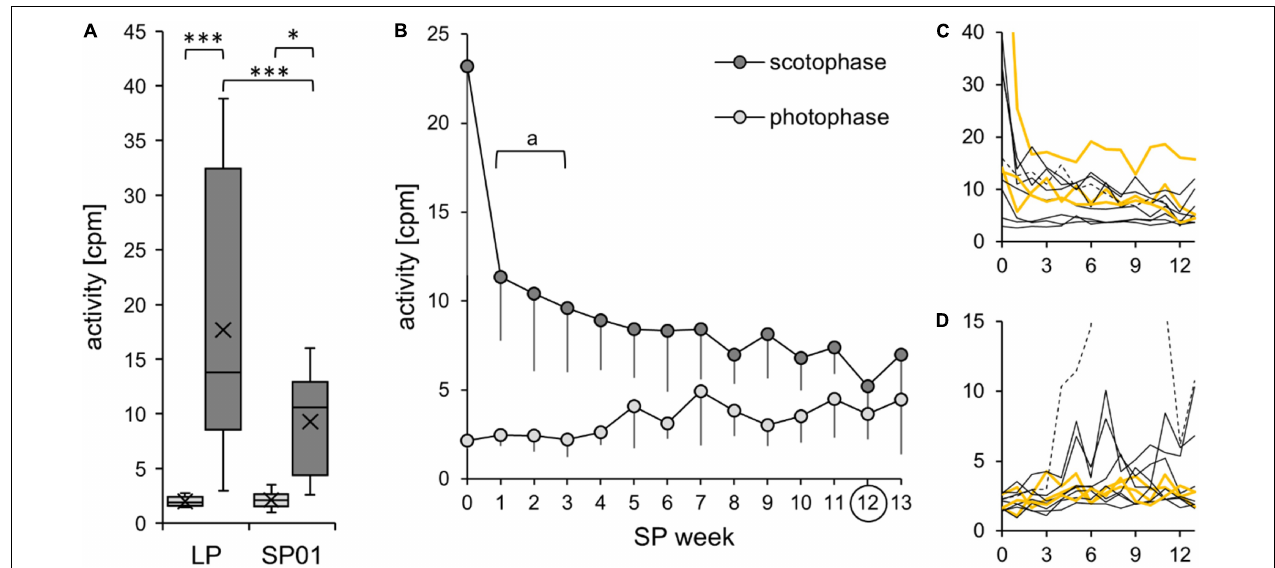
FIGURE 8 | Activity during the short photoperiod adaptation of approach 2. The exact values per hamster can be found in Supplementary Table 6 . (A) The cohort’s initial adaptation of activity after the change of the light regime ( n = 10). Comparison of activity during photophase ( light gray ) and scotophase ( dark gray ) of the last week of the long photoperiod ( LP ) and the first week of the short photoperiod ( SP01 ). According to the two-way repeated measures ANOVA, the activity was affected by both time frame [ F ( 1 , 9 ) = 21.155, p = 0.001, power = 0.984] and light regime [ F ( 1 , 9 ) = 7.689, p = 0.022, power = 0.637]. In addition, there was an interaction between the effects of time frame and light regime [ F ( 1 , 9 ) = 7.815, p = 0.021, power = 0.645]. Post hoc Holm–Sidak tests confirmed that the activity was significantly higher in LP scotophase (*** p < 0.001) and in SP01 (* p < 0.026) compared to that in photophase. Furthermore, scotophase activity was higher in LP than that in SP01 (*** p < 0.001), yet with a low power. Hamster #02 was excluded from the cohort’s model since it had an outlying scotophase activity level in LP (beyond the three times interquartile distance threshold of the cohort), with a drastic initial decrease from 79 cpm during LP scotophase to 25 cpm during SP01 scotophase. (B) Further activity development of the cohort ( n = 6). When comparing the adaptation period from SP01 to SP12, the scotophase activity was reduced. Significant differences to SP12 are indicated with “ a ” [one-way repeated measures ANOVA: F ( 12 , 60 ) = 4.750, p < 0.001, with Holm–Sidak p < 0.001]. The photophase activity slightly rose, yet with a significant difference from SP04 to SP08 only [Friedman repeated measures ANOVA: χ 2 ( 13 ) = 36.229, p < 0.001, with Tukey’s test p < 0.05]. Excluded were hamster #01, with high LP activity and an extremely slow activity adaptation to SP; hamster #02, with outlying LP activity; hamster #06, with stereotypic jumping behavior in the cage corners during photophase from SP04 to SP11; and the hamsters #10 and #11, which were extremely calm and did not modulate initial activity. (C,D) Individual reduction of body temperature during scotophase (C) and photophase (D) for each of the 11 hamsters. Activity (in counts per minute) is displayed on the y -axis, the SP week on the x -axis with hamster #06 as dotted line , the three “never torpor” hamsters as yellow lines , and all others as thin black lines